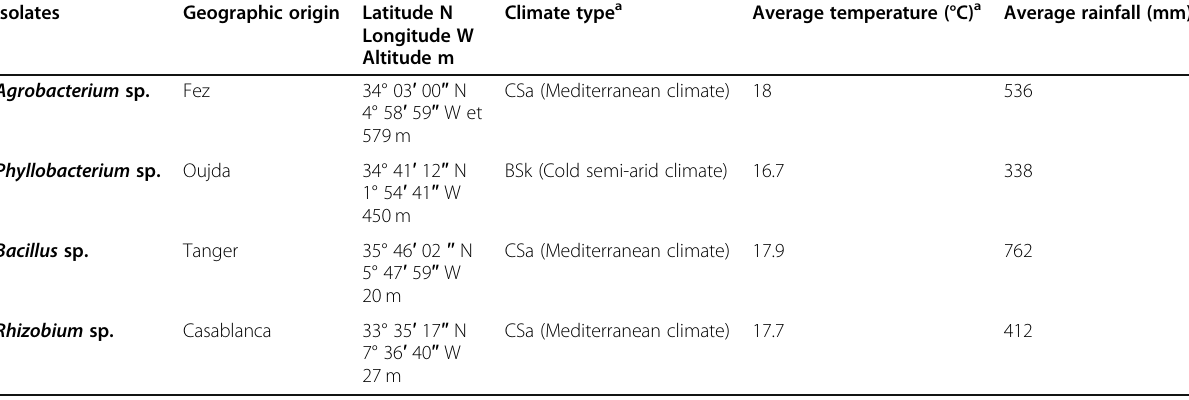
Table 1 Geographic origin, geodesic coordinates, and climate type of the sampling sites